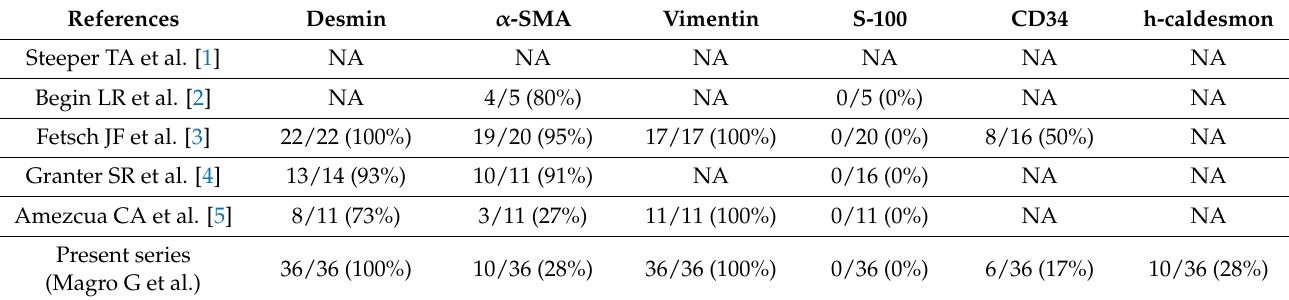
Table 3. Comparative immunohistochemical findings in the largest reported series of primary